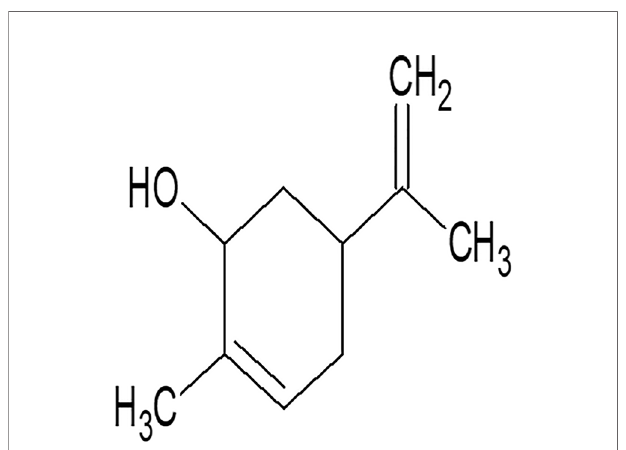
FIGURE 1 | Chemical structure